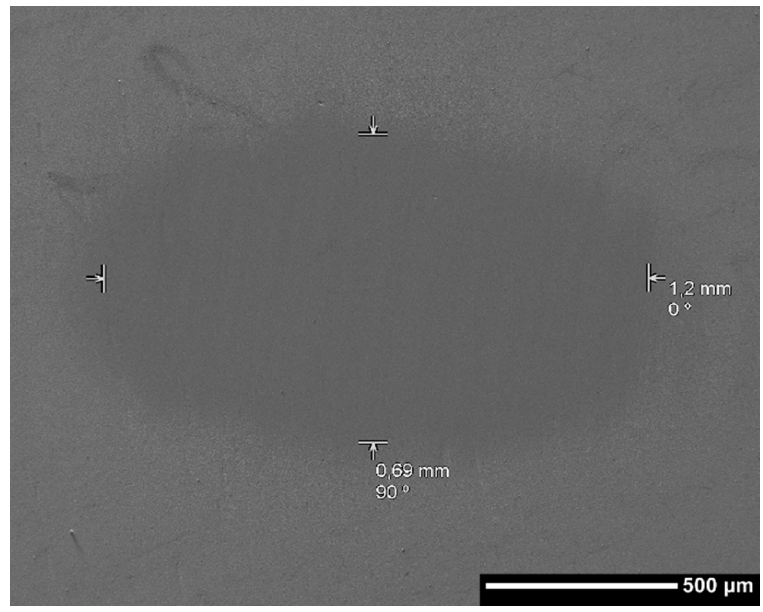
Figure 4. Micrograph of the wear scar length measure through SEM technique.